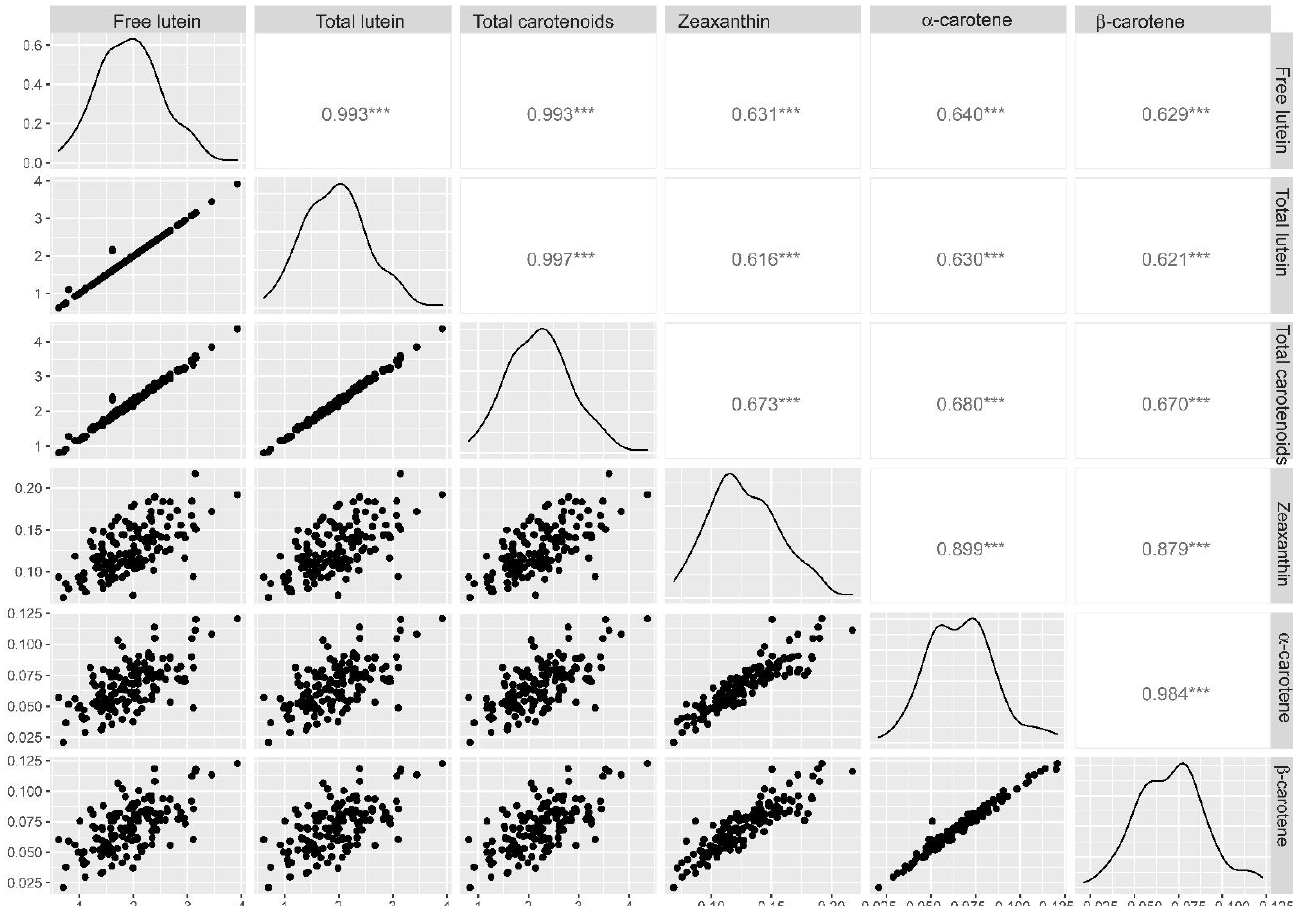
Figure 2. Pearson correlations between seasons and density functions, showing the distribution of traits in both seasons (BLUEs values). *** p < 0.001.